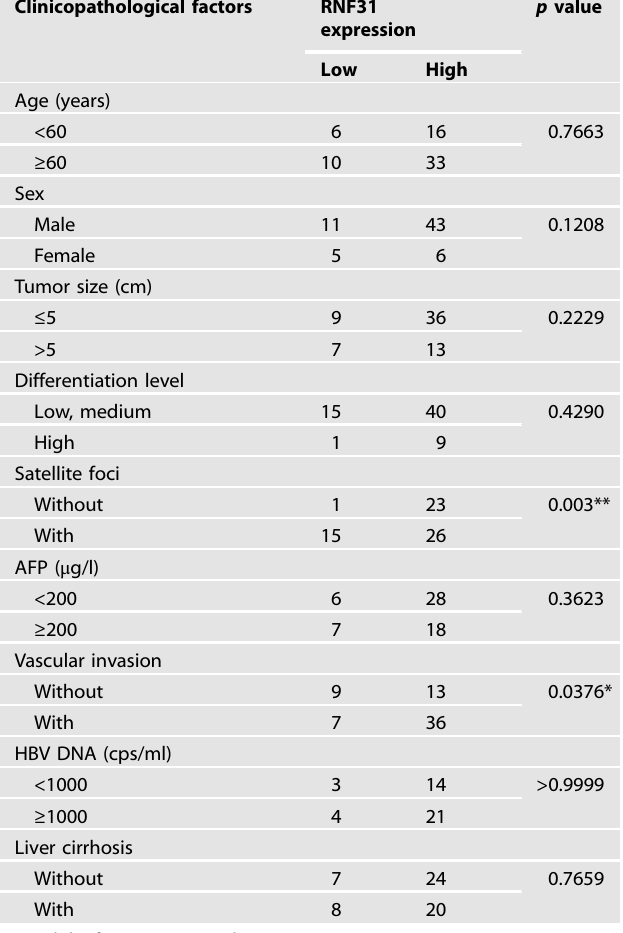
Table 1. Correlation between RNF31 score in HCC and clinicopathological